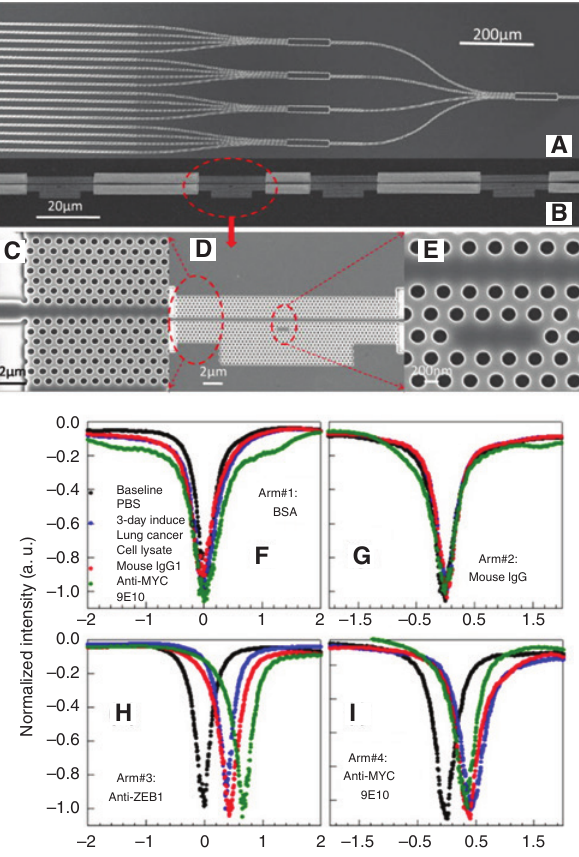
Figure 22: Multiplexed sensing with PhCs. (A)–(E) SEM images of a multiplexed biosensing architecture with 16 arms of cascaded PhC microcavities. (A) is an image of the entire device, and (B) is that of an arm with four cascaded PhC microcavi- ties. (C)–(E) are zoomed-in images of such a PhC microcavity, com- posed of an engineered L3 PhC microcavity two rows away from a W1 PhC waveguide. Adapted from [183] and [187]. (F)–(I) Simultaneous, specific detection of ZEB1 in lung cancer cell lysates with four arms of multiplexed L13 PhC microcavities coupled to their respective W1 PhC waveguides. The resonant wavelength positions for the base line (black), lung cancer cell lysates (red), mouse IgG1 (blue), and anti-MYC 9E10 (green). Adapted from